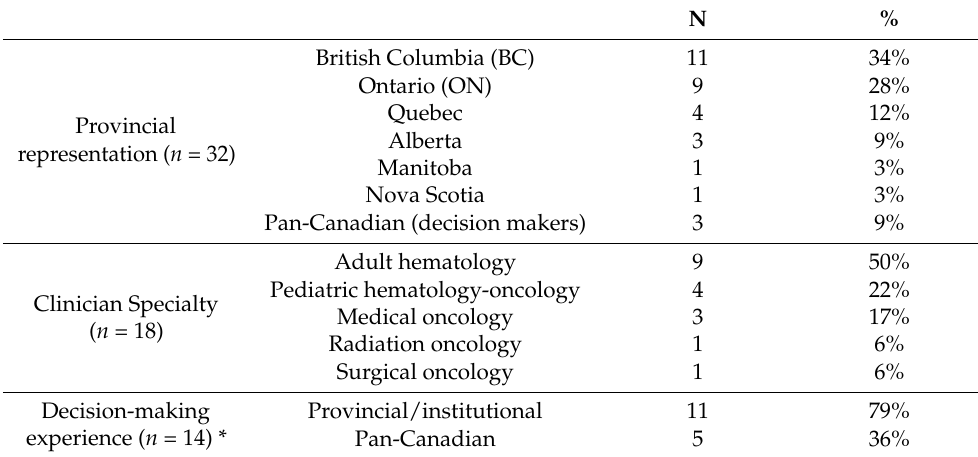
Table 2. Interview participant